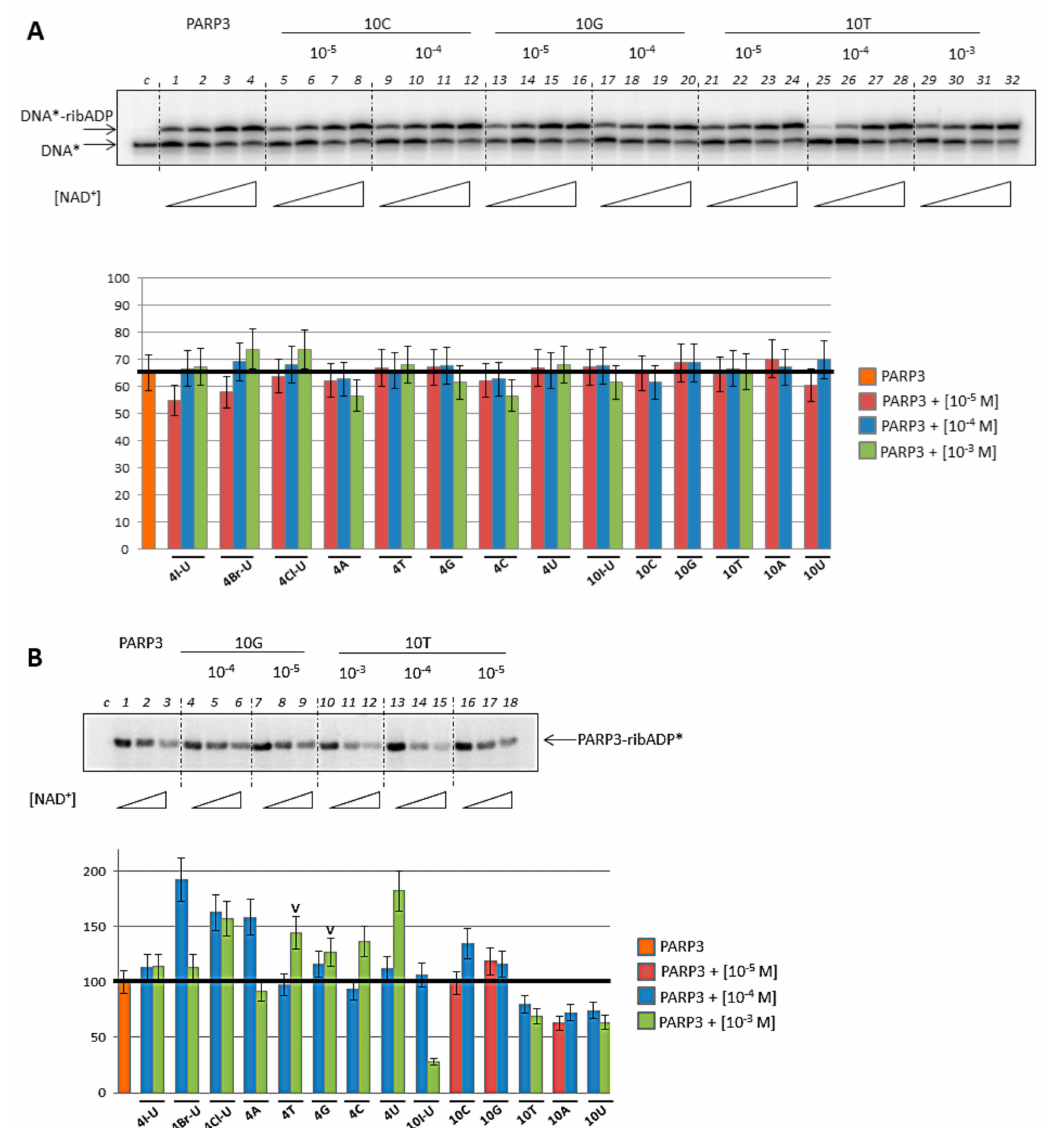
Figure 4. Basic activity of PARP-3 in DNA ( A ) and protein ADP-ribosylation ( B ) and the influence of the inhibitors on these reactions. ( A ) Activity of PARP-3 on [ 32 P]-labeled one-window gapped DNA substrate in the absence (lanes 1–4) or presence of inhibitors in the di ff erent concentrations (lanes 5–32) on the upper panel. The reactions were performed using increasing concentration of NAD + . Lane c corresponds to initial electrophoretic mobility of the DNA substrate. The chart on the bottom panel is reflected of the reaction yield of the ADP-ribosylated DNA in percentage terms. ( B ) Activity of PARP-3 on gap1 DNA substrate in the absence (lanes 1–3) or presence of inhibitors in the di ff erent concentrations (lanes 4–18) on the upper panel. The reactions were performed using increasing concentration of NAD + in the presence of [ 32 P]-labeled NAD + . Lane c corresponds to reaction mixture without PARP-3. The chart on the bottom panel is reflected of the reaction yield of the ADP-ribosylated PARP-3 in the presence of inhibitor normalized on the yield of the autoribosylation of PARP-3 in percentage terms. The ticks on the chart mark the bars with the 0.5 mM of inhibitor in the